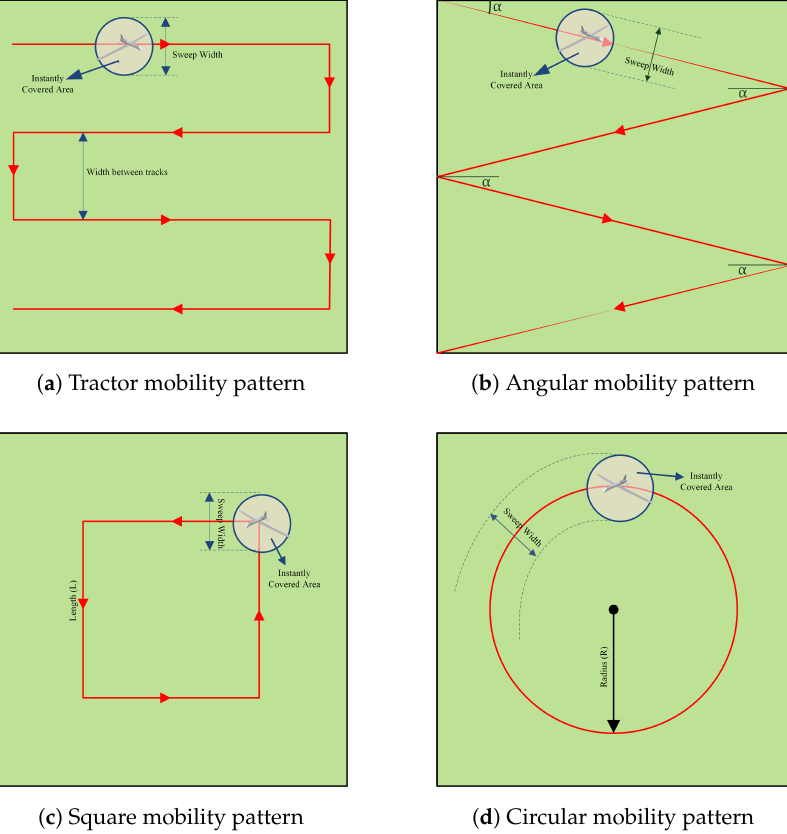
Figure 3. Illustration of explored mobility